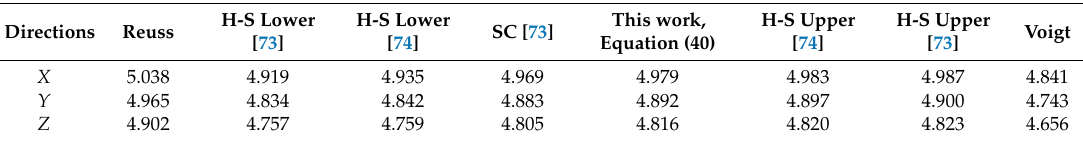
Table 4. Comparison of the longitudinal velocities (in km / s) at di ff erent propagation directions for a macroscopically orthotropic copper with equiaxed grains [73,74]. Hashin–Shtrikman (H-S) bounds